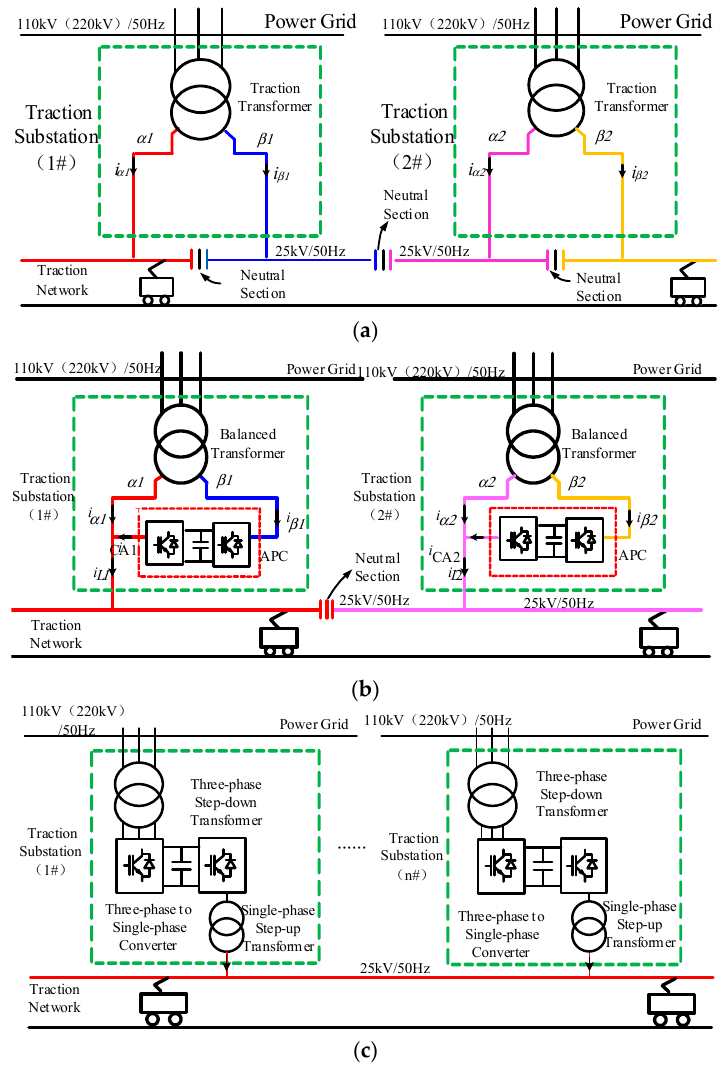
Figure 1. Traction Power Supply System. ( a ) Existing traction power supply system. ( b ) Co-phase traction power supply system. ( c ) Configuration of advanced traction power supply system.